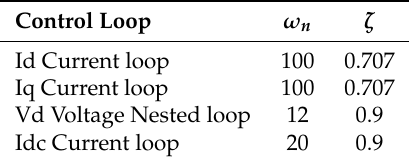
Table 3. Design parameters for PI